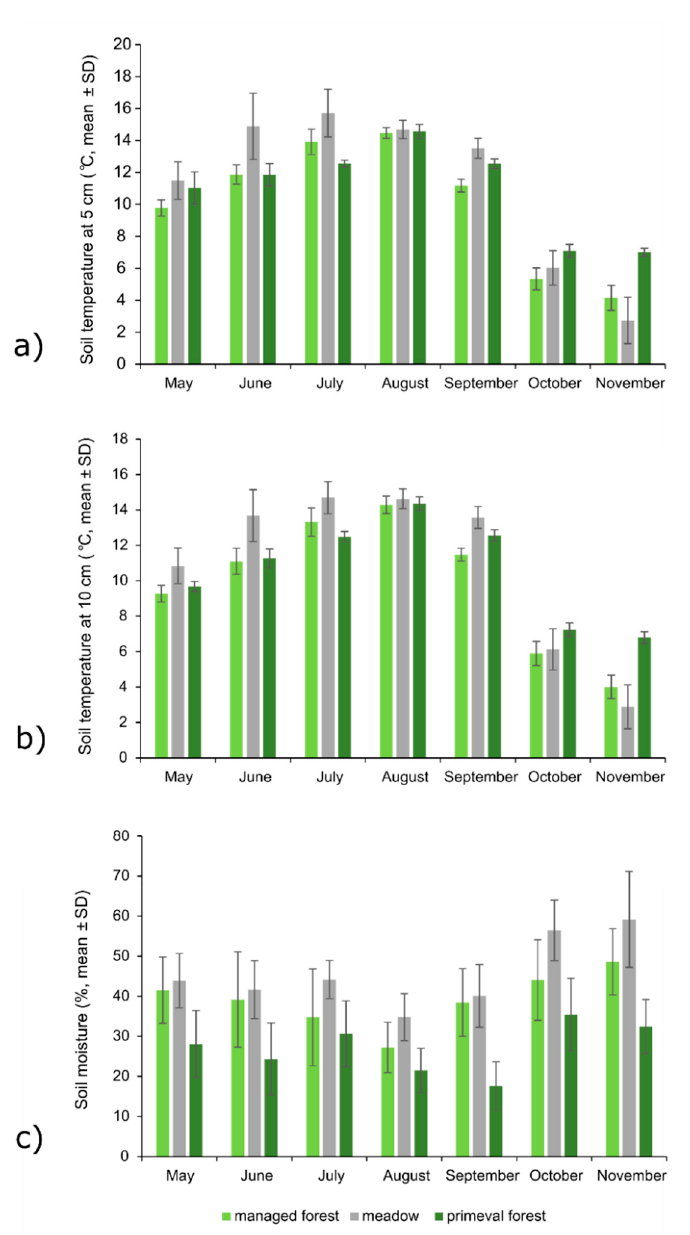
Figure 4. ( a ) Soil temperature measured at 5 cm below the surface, ( b ) soil temperature measured at 10 cm below the surface, ( c ) soil moisture measured at 15 cm below the surface. Soil properties were measured during the vegetation season of 2009, in the Gorski Kotar and Lika regions (Croatia), with the following number of measurements per habitat type: n (managed forest) = 126, n (meadow) = 168, n (primeval forest) = 84.